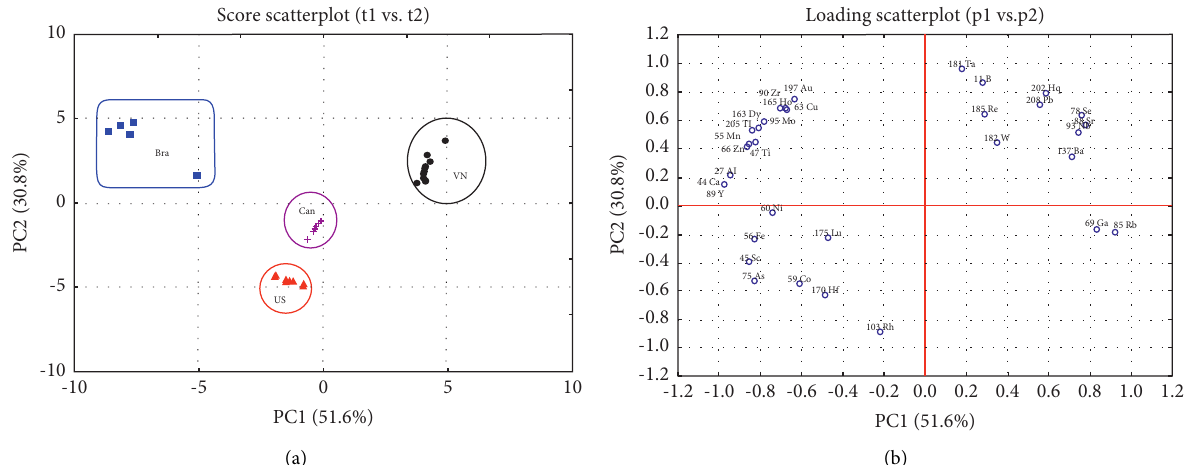
Figure 3: PCA score (a) and (b) loading plots of soybean samples. VN: Vietnamese samples; Can: Canadian samples; Br: Brazilian samples; US: the US